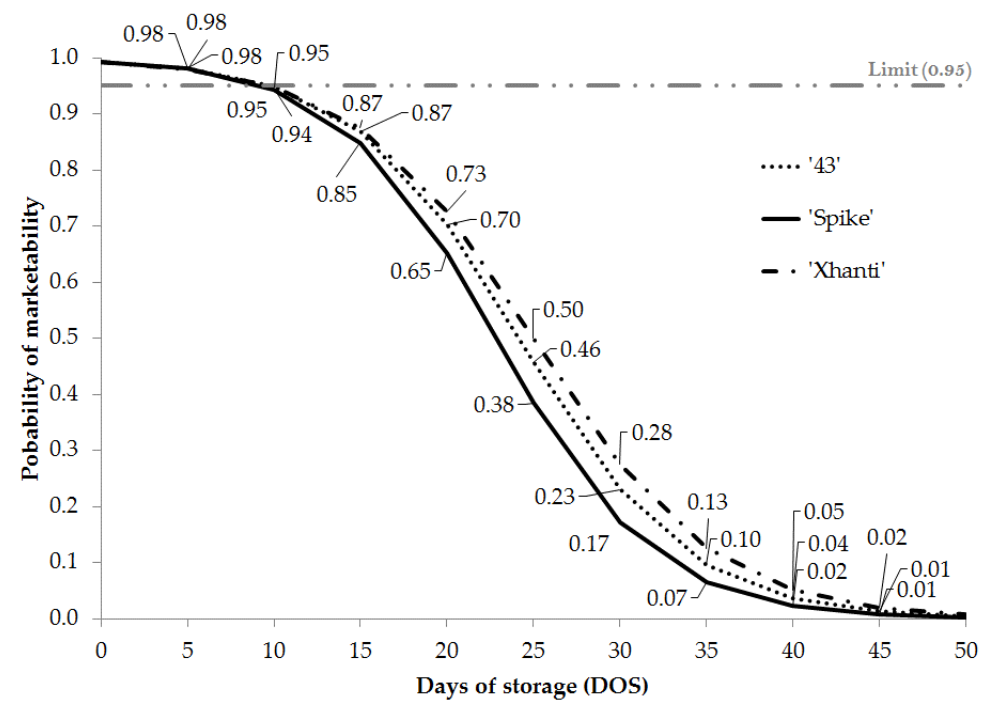
Figure 4. Time evolution of the probability of marketability for each Tribelli XL ® pepper cultivar (‘43’, ‘Spiker’, and ‘Xhanti’). The results come from the simple independent logistic model for each cultivar, as a function of the number of days of storage (DOS).